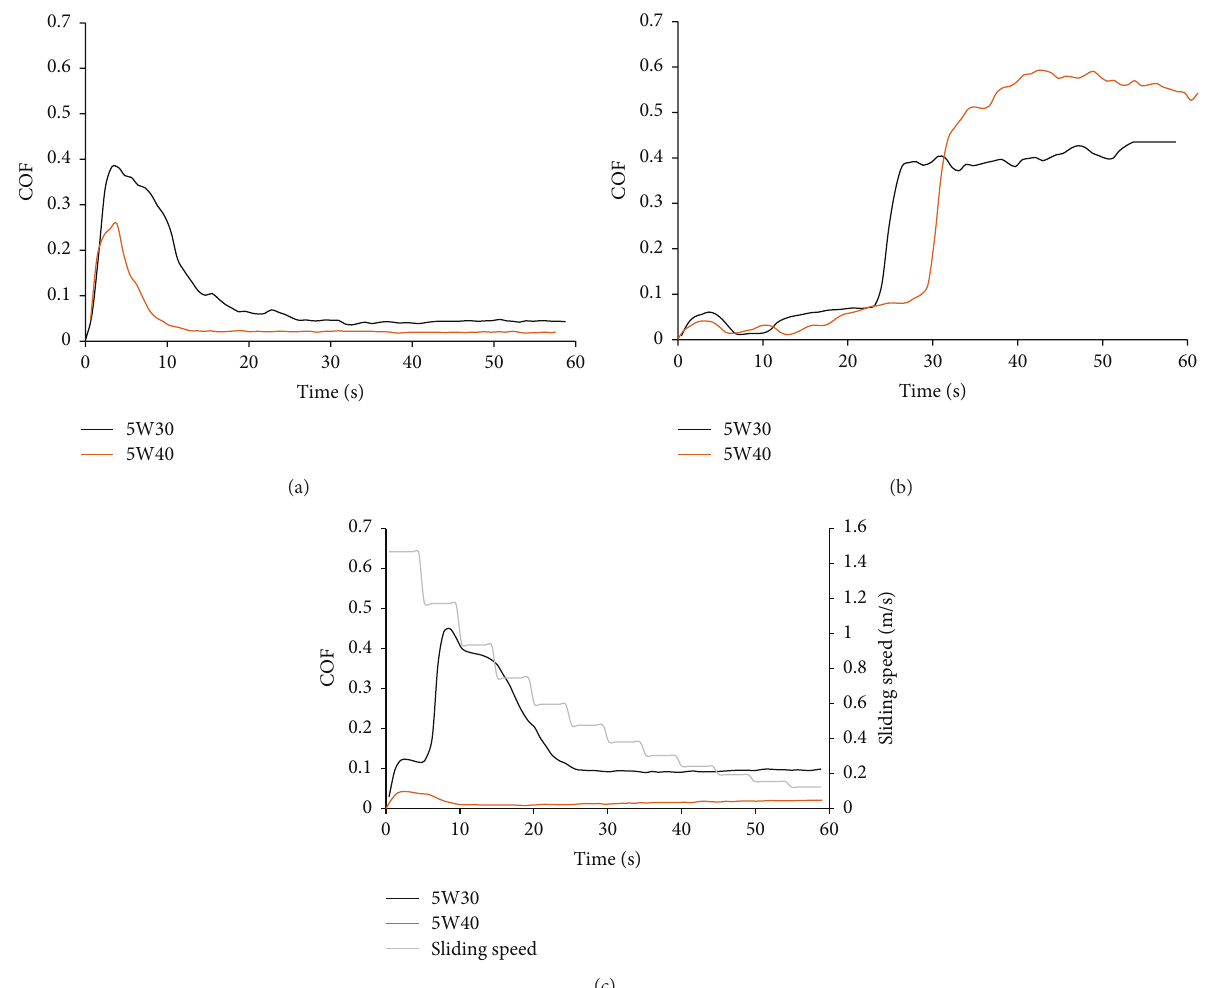
Figure 2: Friction coefficient (COF) of motor oil 5W30 and 5W40. (a) fixed point condition and circular geometry, (b) migrating point condition and spiral geometry, and (c) fixed point- variable speed condition and circular geometry.